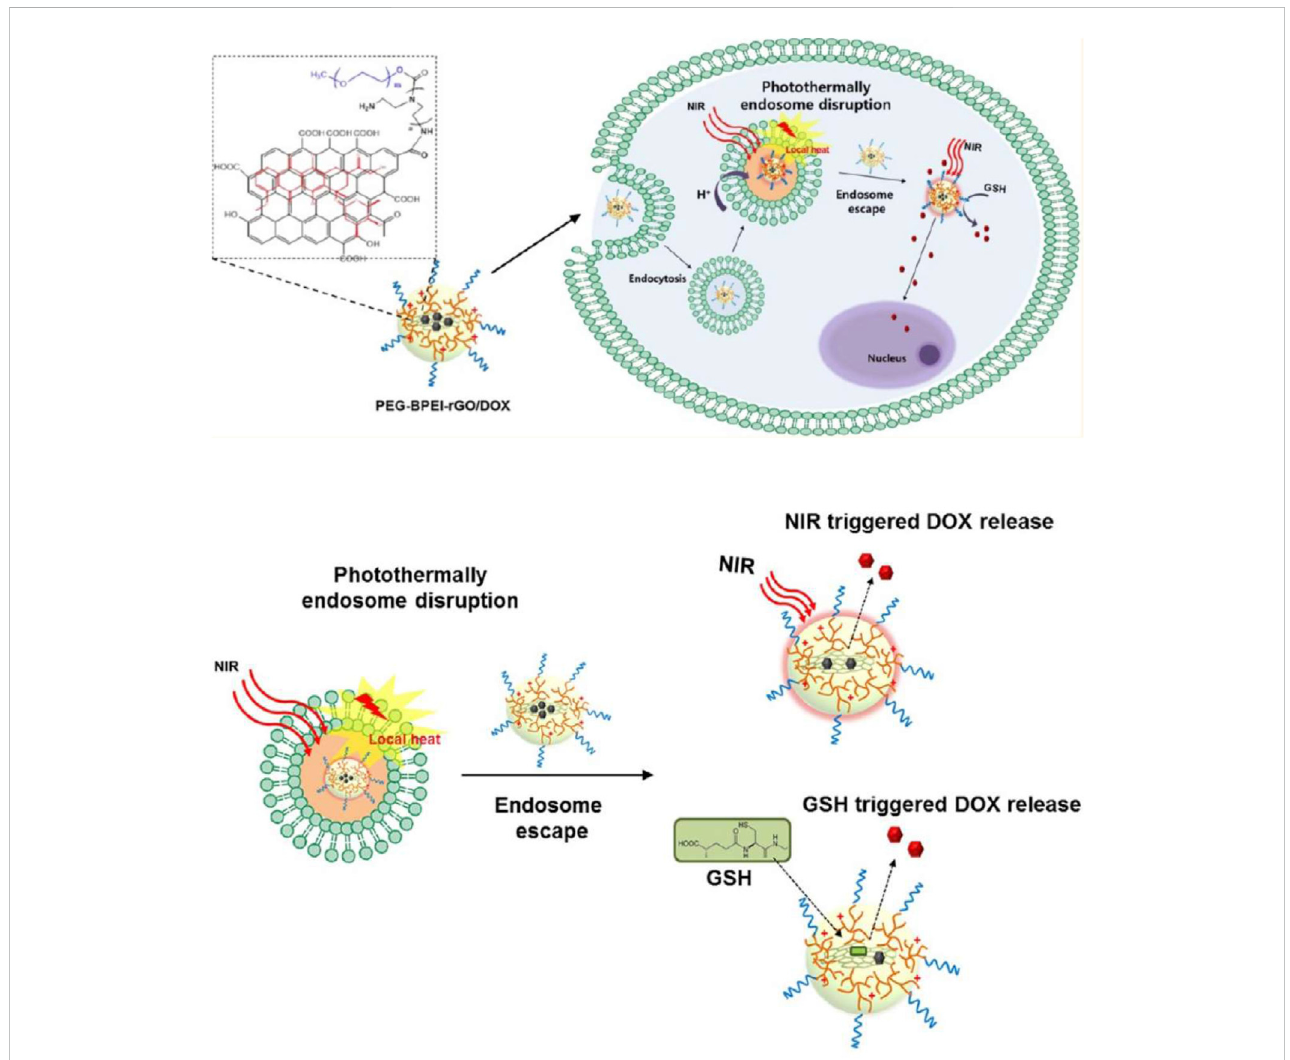
FIGURE 2 Schematic representation of the mechanism of cytosolic drug release by near-infrared (NIR) radiation and glutathione (GSH) after photothermally induced endosome disruption, reprinted with permission from Kim et al. (2013), copyright 2013, American Chemical Society.